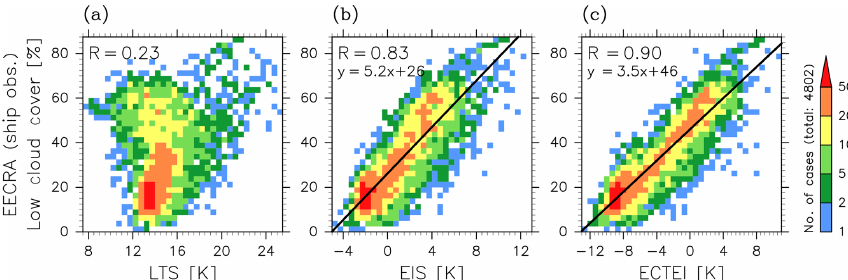
Figure 13. Frequencies of the occurrence of low stratiform cloud cover (combined cloud cover of stratocumulus, stratus and sky-obscuring fog) sorted by (a) LTS, (b) EIS and (c) ECTEI ( β = 0 . 23), based on all 5 ◦ × 5 ◦ seasonal climatology data. Data are the same as in Fig. 12, but all the data between 60 ◦ N and 60 ◦ S for all seasons were used. Linear regression lines and the correlation coefficients are